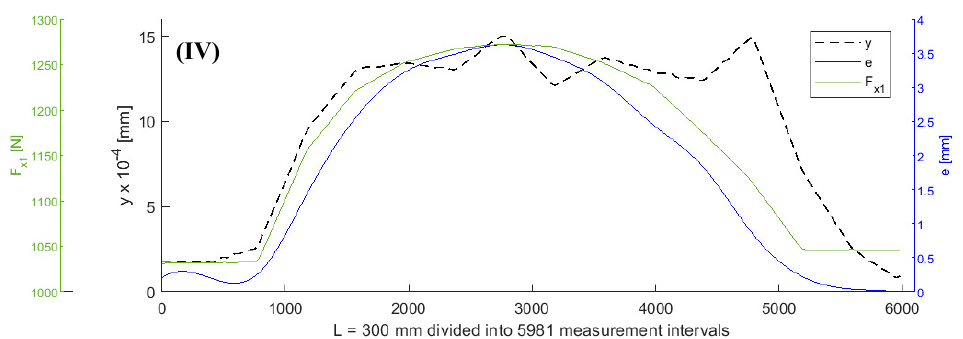
Figure 6. Curves of objective function y, tensile force Fx 1 , and eccentric e for d = 8 mm, F be =147 N, Fx 10 = 980 N, L = 300 mm, F f = 196 N.